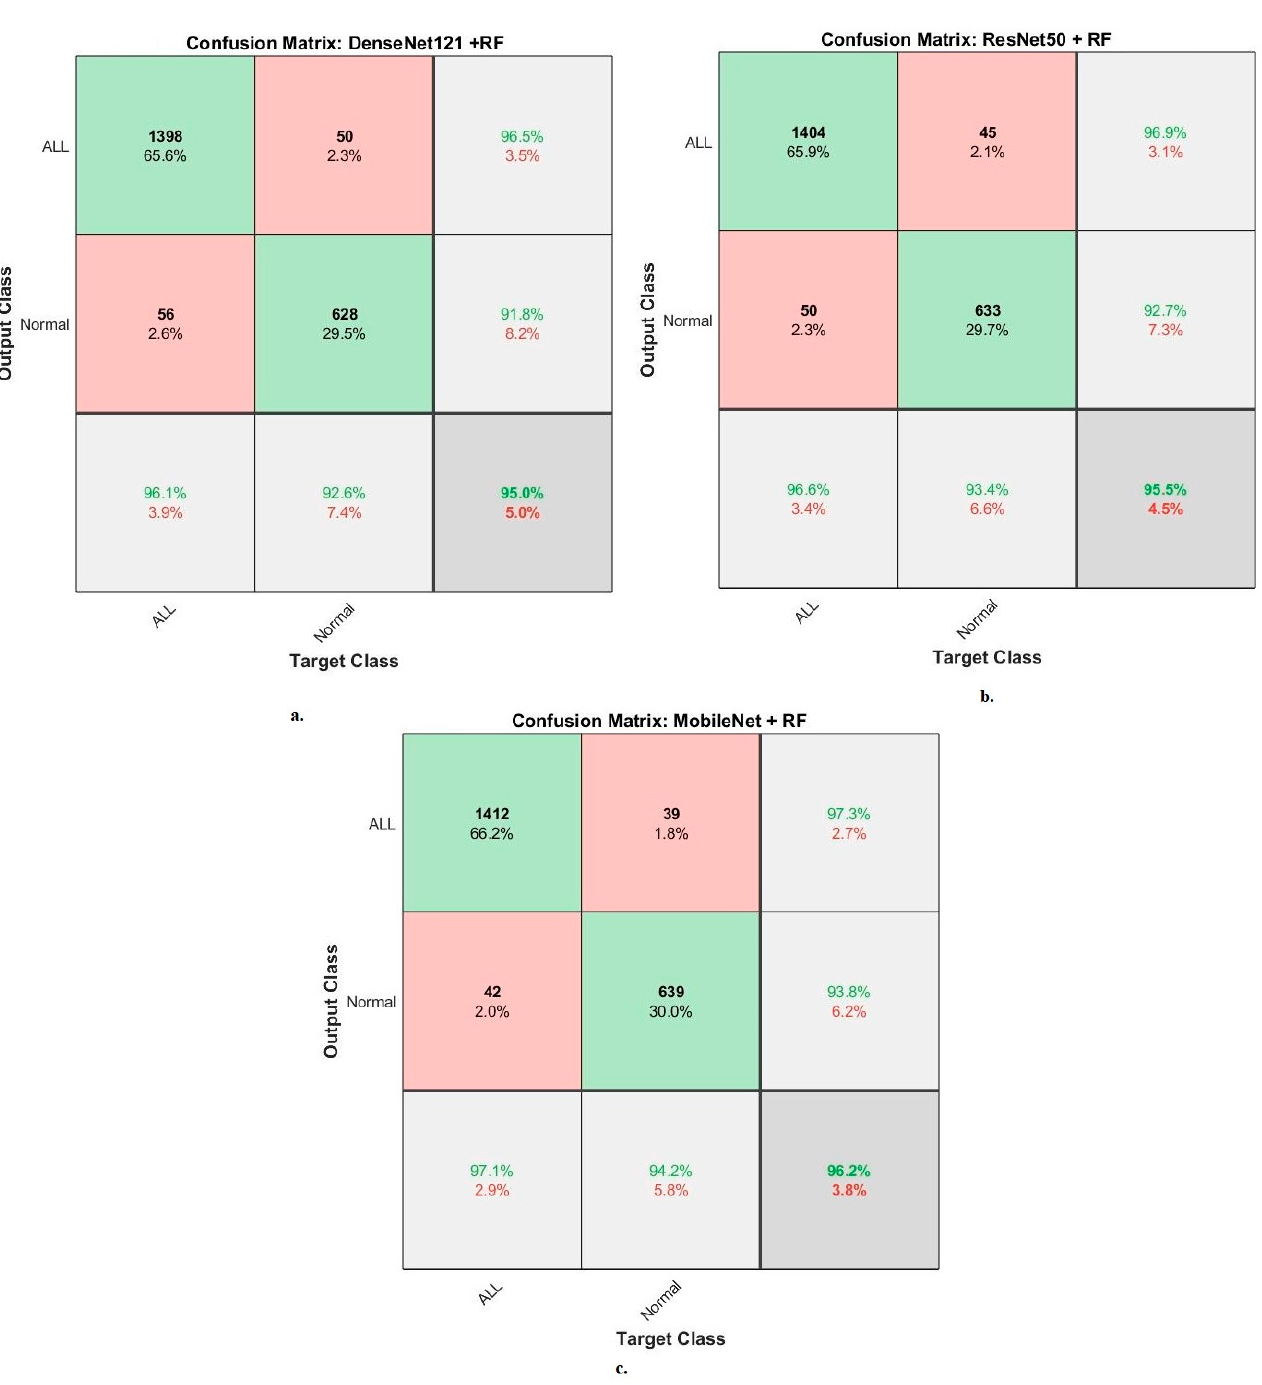
Figure 10. Results of the RF classifier based on the features of the CNN models of the C-NMC 2019 dataset for the diagnosis of acute leukemia confusion matrix of ( a ) DenseNet121-RF. ( b ) ResNet50-RF. ( c ) MobileNet-RF.